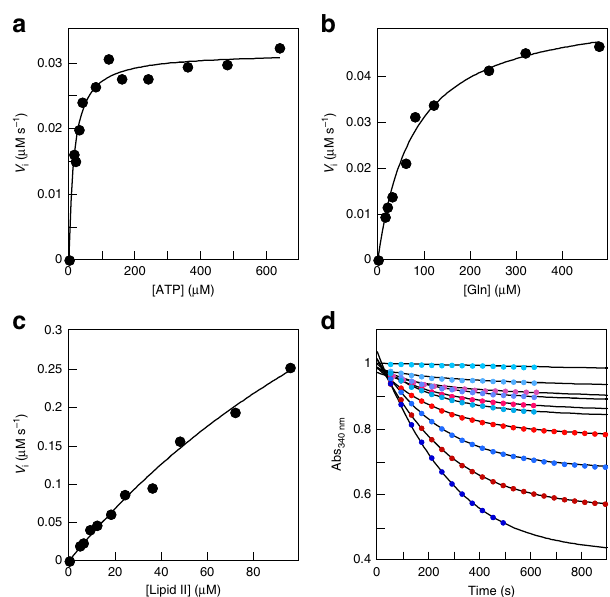
Fig. 2 Enzyme kinetics of MurT/GatD. Reactions were performed at pH 7.5 and 30 °C in 50 mM HEPES, 150 mM NaCl, 10 mM MgCl 2 , 2 mM TCEP and 1% DDM. The generation of ADP was followed by its phosphorylation by a pyruvate kinase using phosphoenolpyruvate as phosphate donor. The generated pyruvate was reduced into L-lactate by a lactate dehydrogenase consuming NADH, which was followed by its absorbance at 340 nm. The concentration of MurT/GatD, lipid II, ATP and L-Gln were 190 nM, 10 μ M, 2 and 10 mM, respectively, unless they were the varying component. a – c Initial velocities for the reaction with varying concentrations of L-Gln, ATP and lipid II, respectively. The solid curves represent the best fi ts to the data of the Michelis-Menten equation (parameters apparent K M and V max are given in Table 1). d Reaction progress curves with concentrations of lipid II varying between 0 and 80 μ M. The blue and red points are two independent data sets (3% of the data points are shown). Solid curves represent the best global fi ts to the two data sets of a Michaelis-Menten model of the reaction (parameters apparent K D and k cat are given in Table (Fig. 3c). Helices α 8 and η 7 interact with GatD. This domain forms a Rossmann fold 28 that superimposes onto those of Mur ligases with r.m.s.ds of 2.9 – 3.4 Å over 129 – 159 residues (shown